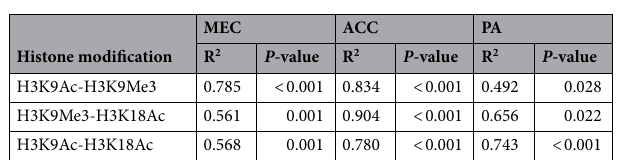
Figure 7. Receiver operating characteristic (ROC) curves and area under curves (AUC). The predictive assessments of the H3K9Me3 level and advanced pathologic grade MEC ( A ), the H3K9Me3 level and MEC with high Ki-67 proliferative index ( B ), the levels of 3 histone H3 modification and solid subtype of ACC ( C ), and the levels of 3 histone H3 modification and ACC with high Ki-67 proliferative index ( D ).